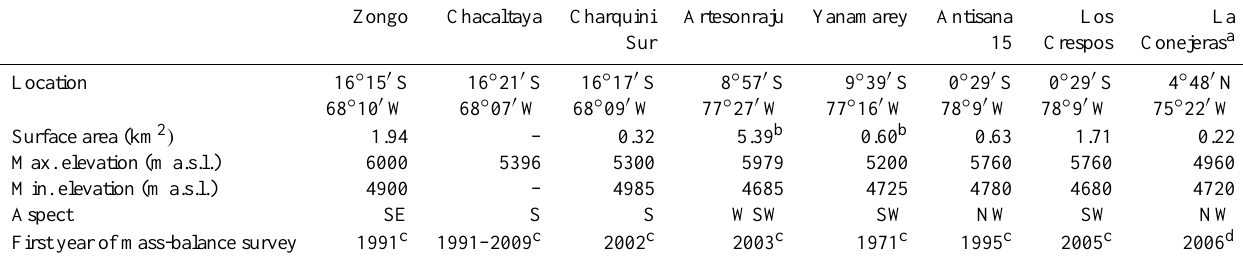
Figure 1. a): Glaciers monitored in the tropical Andes. Glaciers with long-term mass balance series 1225 (small red hexagons) are labeled (see Table 1 for details). For these glaciers length (yellow cube) 1226 and area (blue circle) records also exist. The large red hexagon depicts a sample of 21 glaciers in 1227 Table 1. Characteristics of the glaciers monitored and date of the beginning of the observations. the Cordillera Real, Bolivia, for which mass balance reconstructions are available from 1963 to 1228 Zongo Chacaltaya Charquini Artesonraju Yanamarey Antisana Los La Sur 15 Crespos Conejeras a 2006 (Soruco et al., 2009a). Other glaciers whose changes in length and/or in area are monitored are 1229 Location 16 ◦ 15 0 S 16 ◦ 21 0 S 16 ◦ 17 0 S 8 ◦ 57 0 S 9 ◦ 39 0 S 0 ◦ 29 0 S 0 ◦ 29 0 S 4 ◦ 48 0 N 68 ◦ 10 0 W 68 ◦ 07 0 W 68 ◦ 09 0 W 77 ◦ 27 0 W numbered. ´MB initiated´ indicates glaciers with mass balance measurements starting in 2008 1230 – (Incachiriasca), 2009 (Coropuna) and 2010 (Quisoquipinia). b): General atmospheric circulation 1231 over South America. The dotted frame shows the extent of the precipitation maps in figures 1c and 1232